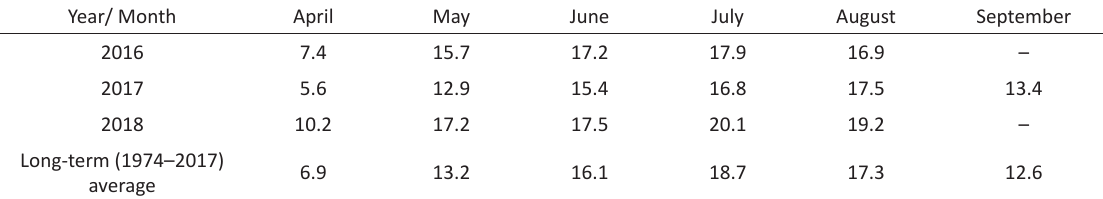
Table 1. Average air temperature across 24 hours during faba bean vegetative seasons, Kaunas Meteorological Station